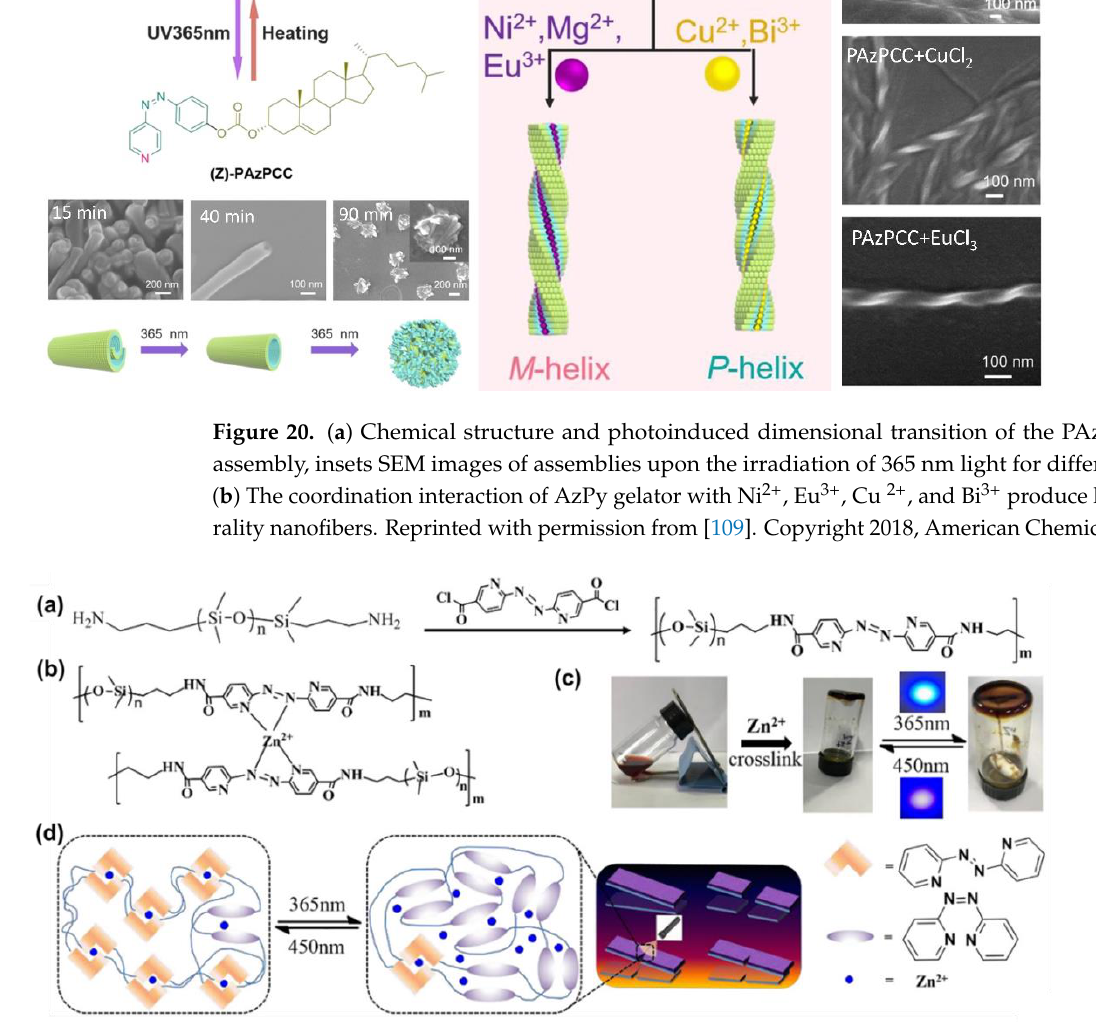
Figure 21. ( a ) The synthetic route of AzPy-PDMS; ( b ) the structure of Zn(AzPy)2-PDMS and ( c ) photographs of the gelation formation of an AzPy -PDMS toluene solution (70 mg/mL, 3 mL) upon the addition of methanol solution of Zn(OTf) 2 (0.18 M, 100 μL); ( d ) The schematic diagram of the light-healing process. Reprinted with permission from [110]. Copyright 2020, Elsevier.